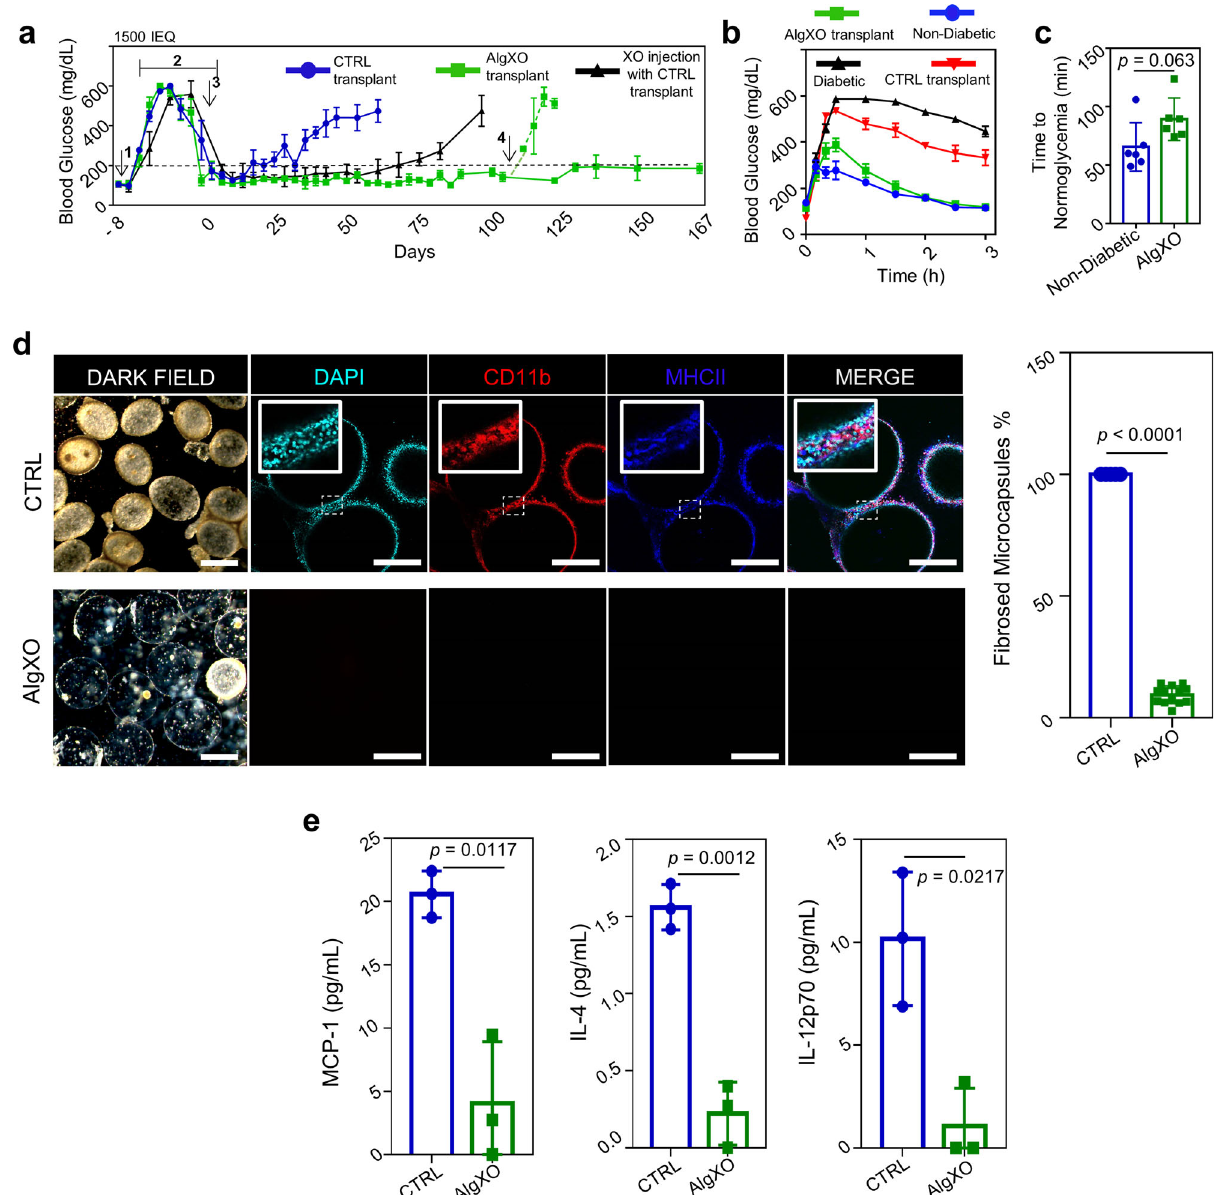
Fig. 1 Islet xenotransplants within AlgXO reverse hyperglycemia in diabetic immunocompetent mice. a Non-fasting blood glucose levels in C57/BL6 STZ-induced diabetic mice ( n = 5 mice) shows that transplantation of 1500 IEQ rat islets within AlgXO provided euglycemia in diabetic mice for >170 days, whereas the CTRL microcapsules failed in <1 month. To further con fi rm that the glycemic correction is merely due to transplants and not pancreatic regeneration in STZ-induced diabetic mice, we washed the i.p. cavity of mice and removed the explants after 105 days of transplantation ( n = 2 mice). Within 18 h of graft removal, mice blood glucose elevated and remained hyperglycemic for the rest of their lifetime (dashed green line). Separate i.p. transplantation of islets within CTRL microcapsules and XOs provided normoglycemia for ~70 days (black line, n = 4 mice). b We further tested the ef fi cacy of AlgXO transplants in response to oral glucose tolerance test (OGTT). One month after transplantation, similar to STZ mice ( n = 6 mice), CTRL microcapsules failed to regulate the glucose levels ( n = 4 mice), whereas AlgXO transplants successfully reversed hyperglycemia event induced by glucose challenge ( n = 6 mice), with similar trend as non-diabetic controls. c The average time to reach normoglycemia after an OGTT for non-diabetic mice was 65 ± 27 min and for mice with AlgXO transplants was 103 ± 32 min ( n = 6 mice). d After 1 month, both CTRL and AlgXO (from 1500 IEQ group) transplants were removed through washing the i.p. cavity. Next, microcapsules were analyzed for the immune in fi ltration (also known as pericapsular cell growth) with laser-scanning confocal microscopy. Some cells were CD11b + and some of the CD11b + cells were expressing MHCII biomarker. All the collected CTRL microcapsules were found to have pericapsular cells attached to the surface, while the percentage of AlgXO transplants with pericapsular growth was 9.4% ± 3.6%, which was signi fi cantly lower than CTRL transplants ( p < 0.0001). Scale bars are 200 μ m for the dark fi eld and 100 μ m for the fl orescent channels. e The pericapsular cytokine and chemokines present released in the pericapsular area of implants. Results are mean ± SD, and statistical signi fi cance is calculated through unpaired t -test with Welch ’ s correction. 1: STZ injection; 2: Diabetes induction period; 3: Transplantation; 4: Graft removal.